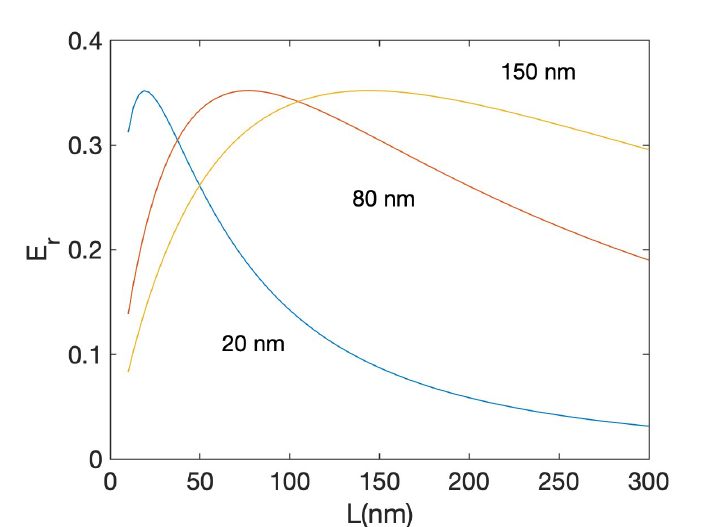
Figure 5. Energy ratio, E r , between two tilted nanocubes of different sizes. The sizes considered are 20 nm (blue line), 80 nm (red line), and 150 nm (orange line). The maximum in each curve happens when the separation equals the size of the